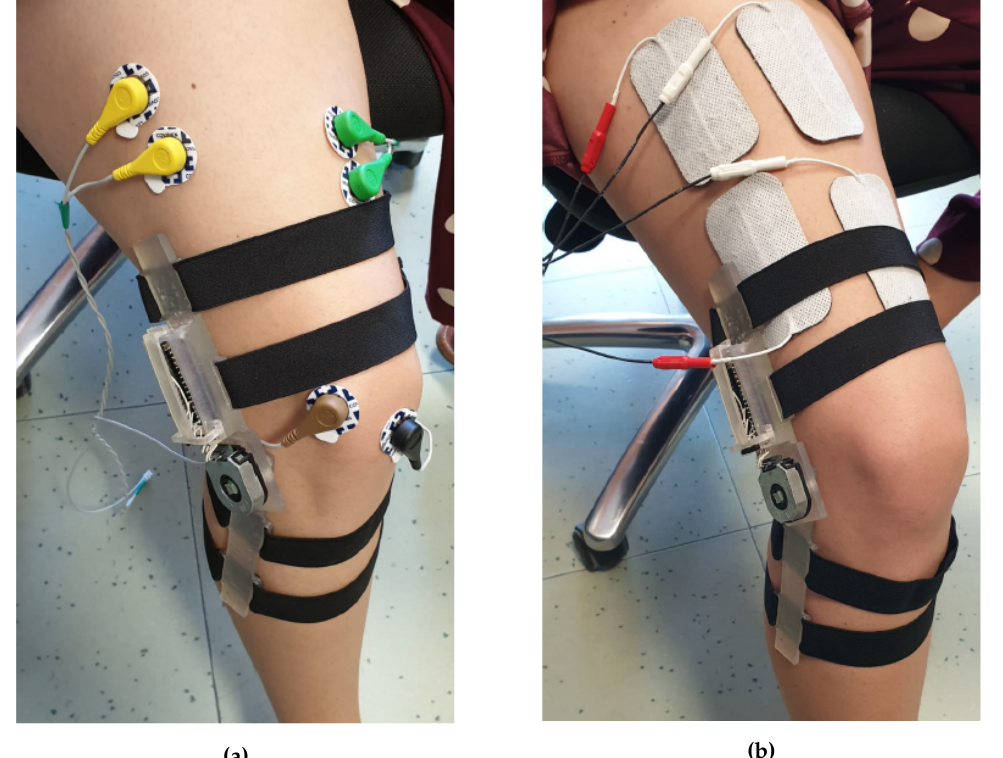
Figure 13. Knee extension exercise. ( a ) sEMG acquisition electrodes on the vastus lateralis and vastus medialis muscles. ( b ) the electrodes are directly placed on the muscle bellies of the vastus lateralis and vastus medialis. This locations and the electrodes dimension also contract the rectus femoris muscle improving the stimulation effectiveness.